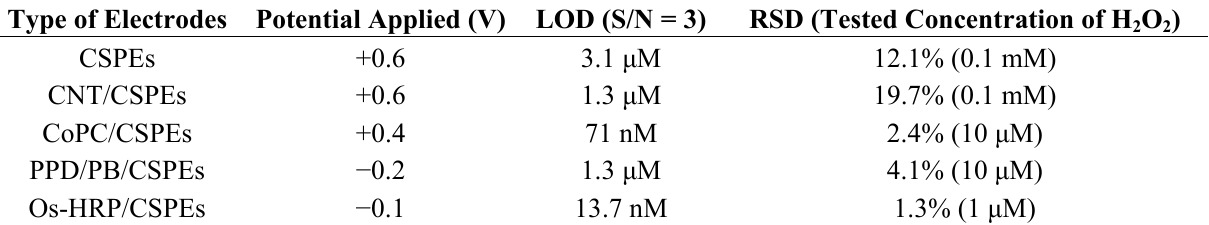
Table 1. Comparison of the amperometric analytical performances for H the five kinds of electrodes prepared in the present